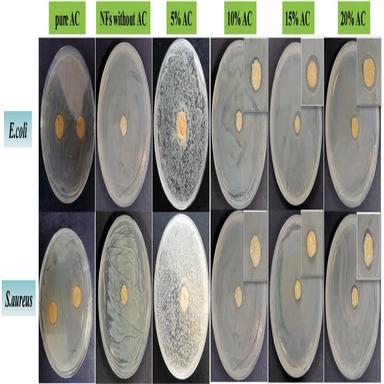
Inhibition zones of the pure AC, the PPI/PUL NFs without AC or with 5%, 10%, 15% and 20% AC against E. coli and S. aureus. All test samples were heated at 120 ◦C for 3 h.